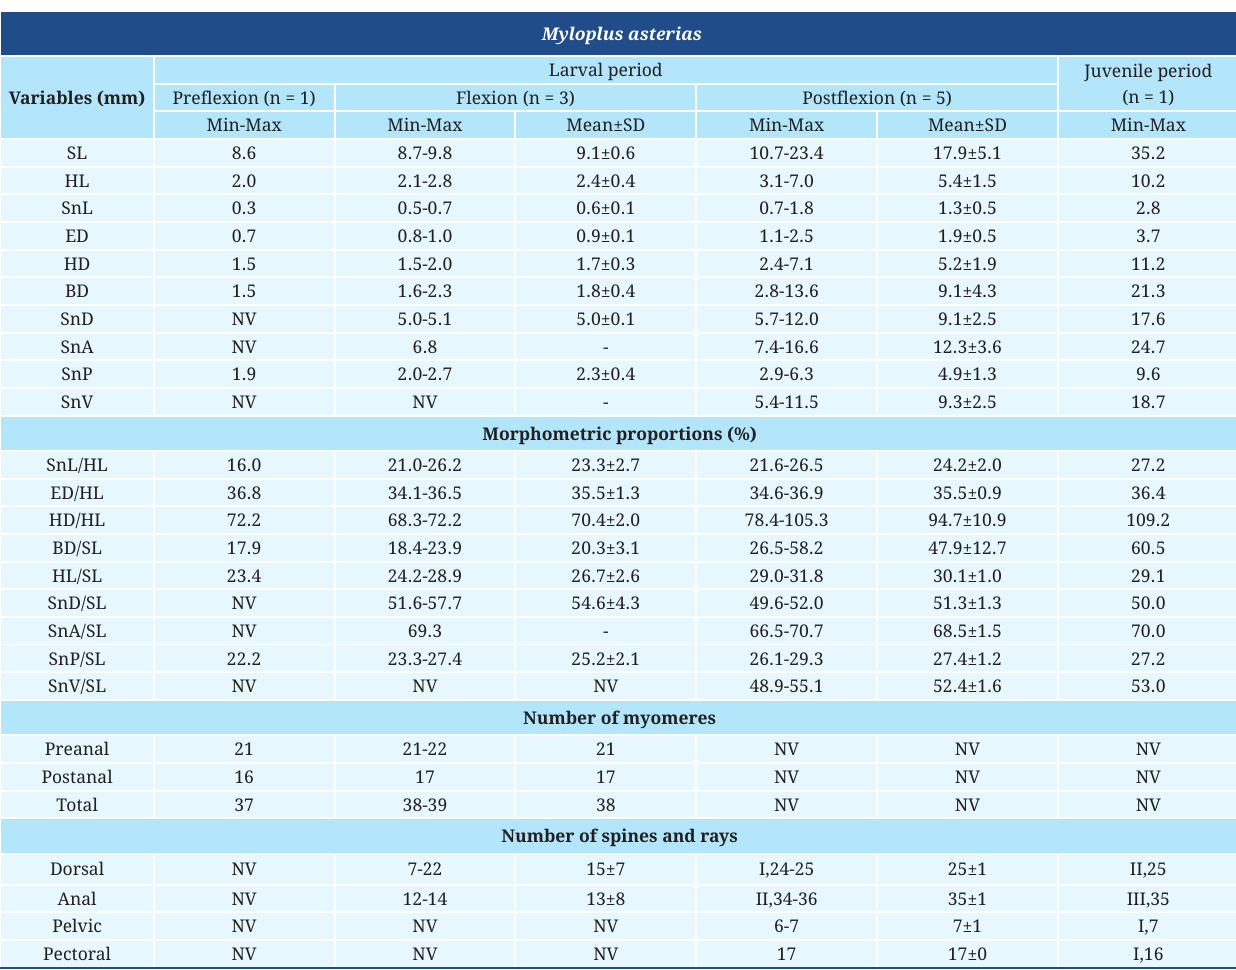
TABLE 1 | Values of minimum (Min), maximum (Max) and mean length (mm) and standard deviation (SD) of morphometric and meristic variables obtained from larvae and juveniles of Myloplus asterias . SL: standard length; HL: head length; SnL: snout length; ED: eye diameter; HD: head depth; BD: body depth; SnD: snout-dorsal fin distance; SnA: snout-anal fin distance; SnP: snout-pectoral fin distance; SnV: snout- pelvic fin distance; NV: not